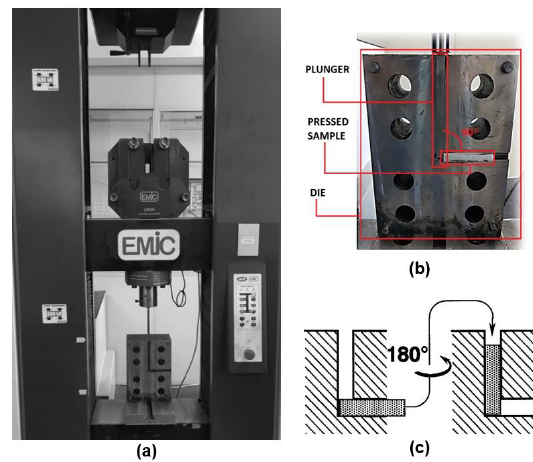
Figure 4. Equal-channel angular pressing ( ECAP ): a) Adaptation of the universal testing machine EMIC-600 for pressing via ECAP, b) Parts of ECAP with pressed sample and c) Schematic representation of route C with three